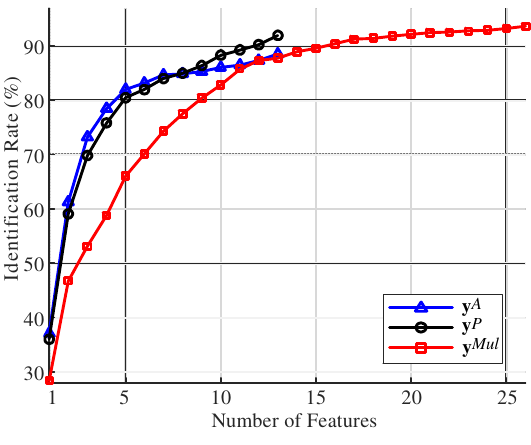
Figure 5. Identification rates for various dimensions of the feature space.